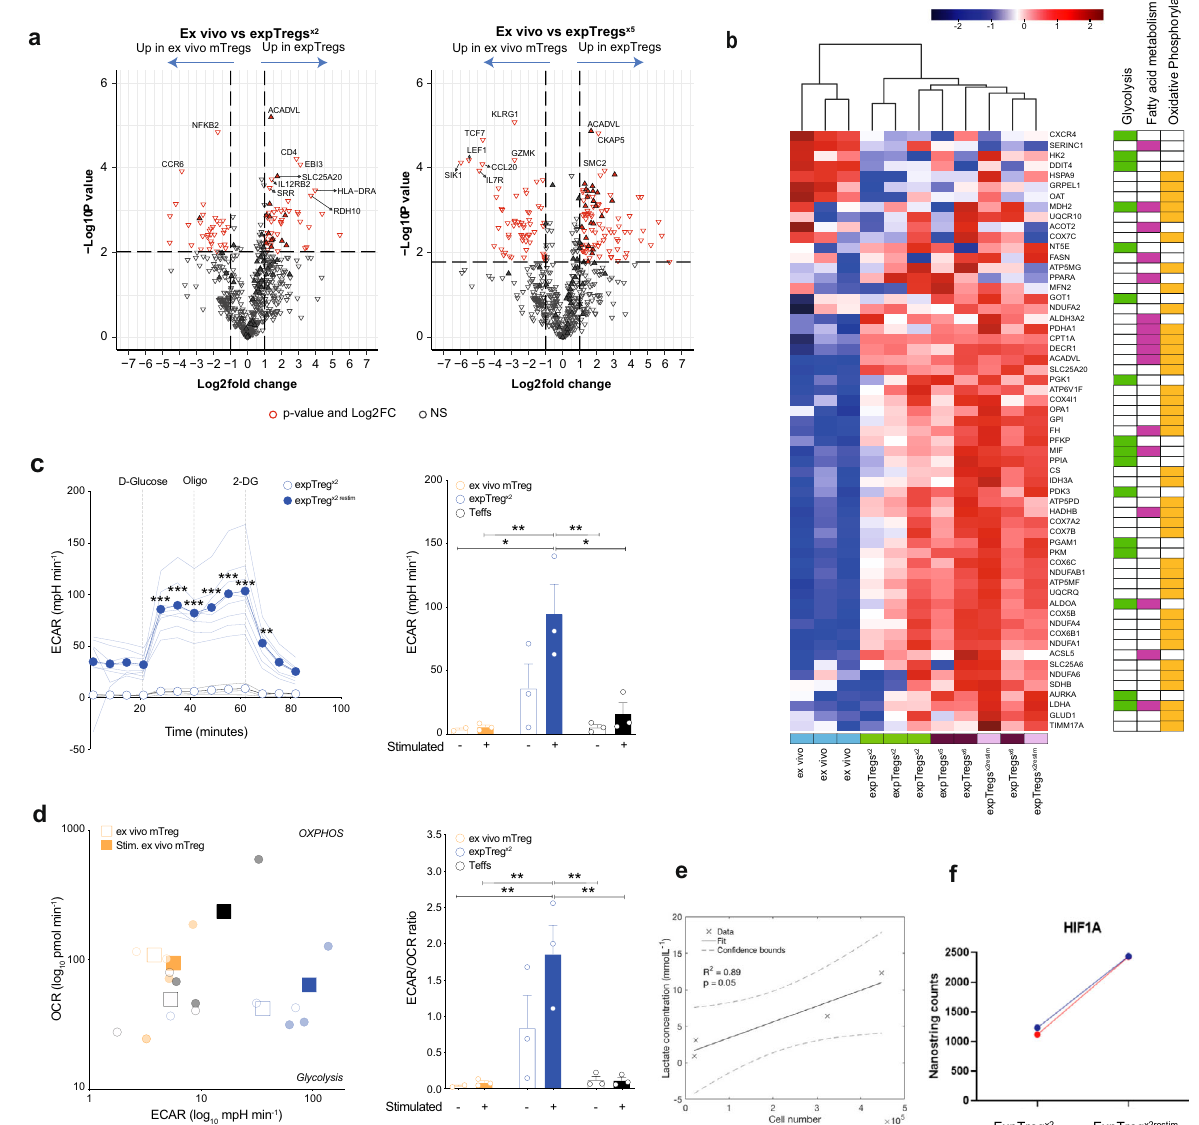
Fig. 4 ExpTregs undergo metabolic remodelling and utilize aerobic glycolysis during their expansion. a Volcano plots of differential gene expression between ex vivo mTregs and resting expTregs (after 2 or 5/6 cycles) measured using Nanostring CAR-T panel. Gene Set Enrichment Analysis (GSEA) using the Hallmark pathways showed enrichment of metabolic genes ( fi lled triangles). b Heatmap showing differential expression of genes involved in glycolysis, fatty acid metabolism and oxidative phosphorylation between ex vivo mTregs, resting expTregs (after 2 or 5/6 cycles) and re-stimulated expTregs (mid-cycle 3). c Representative glycolysis stress test of resting expTregs ×2 and re-stimulated expTregs ×2restim from the same donor showing Extracellular Acidi fi cation Rate (ECAR) changes (left plot). Oligo oligomycin, 2DG 2-Deoxy-D-glucose. Single technical replicates ( ≥ 3) are shown as light lines, mean values are shown as dotted dark lines. Two-way ANOVA. Right plot shows histogram of ECAR values after D-Glucose in ex vivo mTregs, expTregs ×2 and Teffs (unstimulated and stimulated). Single donors ( ≥ 2) are shown as circles, bar graphs show mean values ± SEM. One-way ANOVA. d Metabolic state of each group according to the Oxygen Consumption Rate (OCR) and ECAR after D-Glucose (left plot). Single donors ( ≥ 2) are shown as light circles, mean values are shown as dark squares. ECAR/OCR ratio as indicator of preferential use of glycolysis over OXPHOS (right plot). Single donors ( ≥ 2) are shown as circles, bar graphs show mean values ± SEM. One-way ANOVA. e Lactate in the cell supernatant of expTregs, measured spectrophotometrically, correlated positively with cell number (R 2 .0.89, p = 0.05). f HIF1A expression increased two-fold in expTreg ×2 compared to matched ex vivo Tregs. (* P < 0.05, ** P < 0.01, *** P < 0.001, **** P <